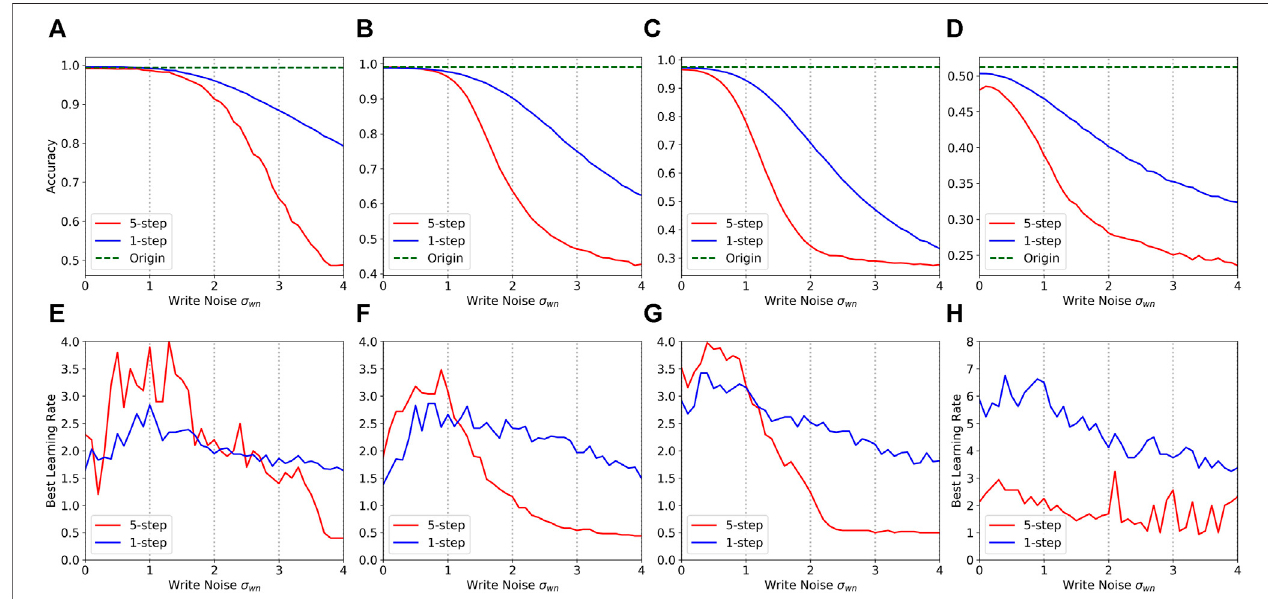
FIGURE3| Comparisonoftheaccuracyof5-stepupdateand1-stepupdateindifferentwritenoiseandtheirbestrelativelearningrateindifferentwritenoise. (A,E) 5way-1shot on Omniglot. (B, F) 10way-1shot on Omniglot. (C, G) 20way-1shot on Omniglot. (D, H) 5way-1shot on MiniImageNet.